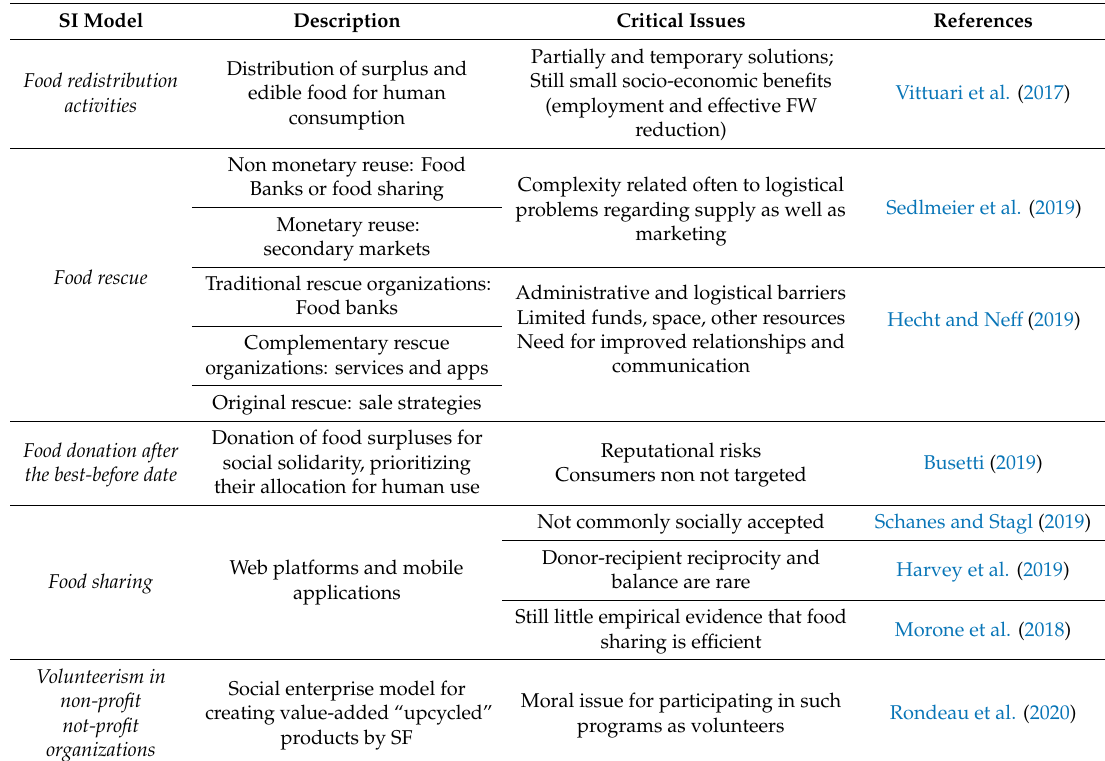
Table 1. Results of the qualitative analysis of the academic